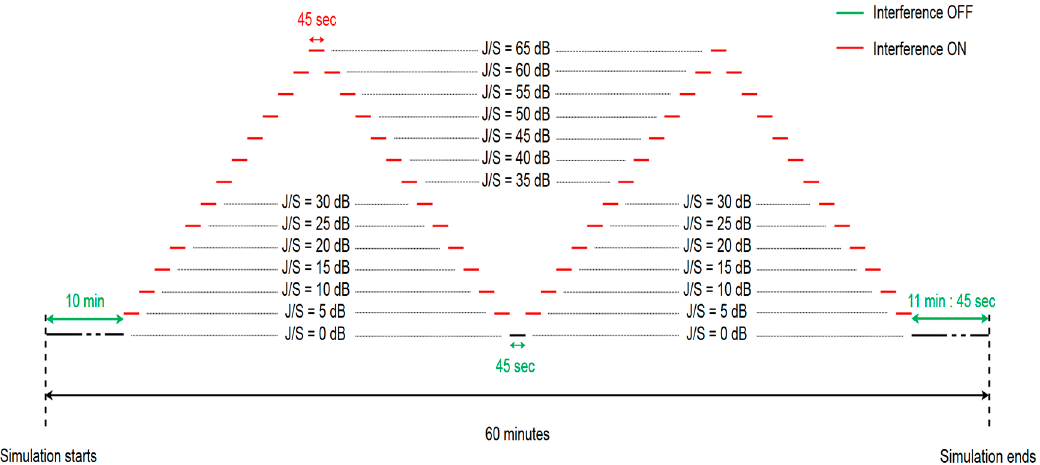
Figure 3. Sensitivity test profile.